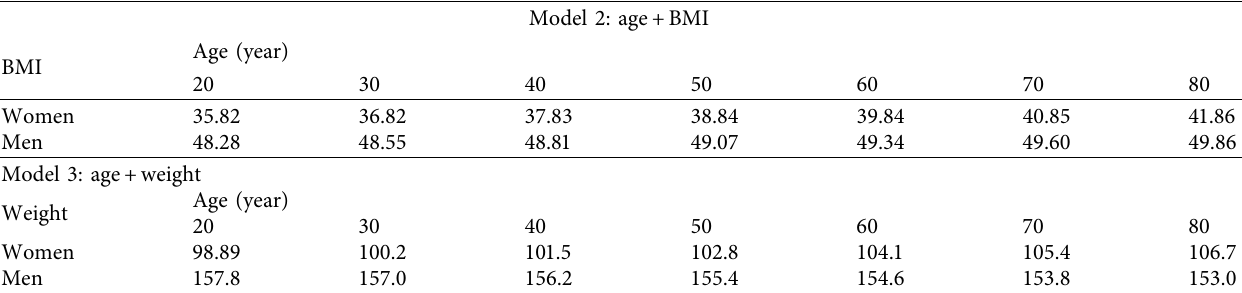
Table 6: BMI chart for women and men at 5th ICS with a failure performance for Model 2 (upper panel); weight chart for women and men at 5th ICS with a failure performance for Model 3 (lower panel).